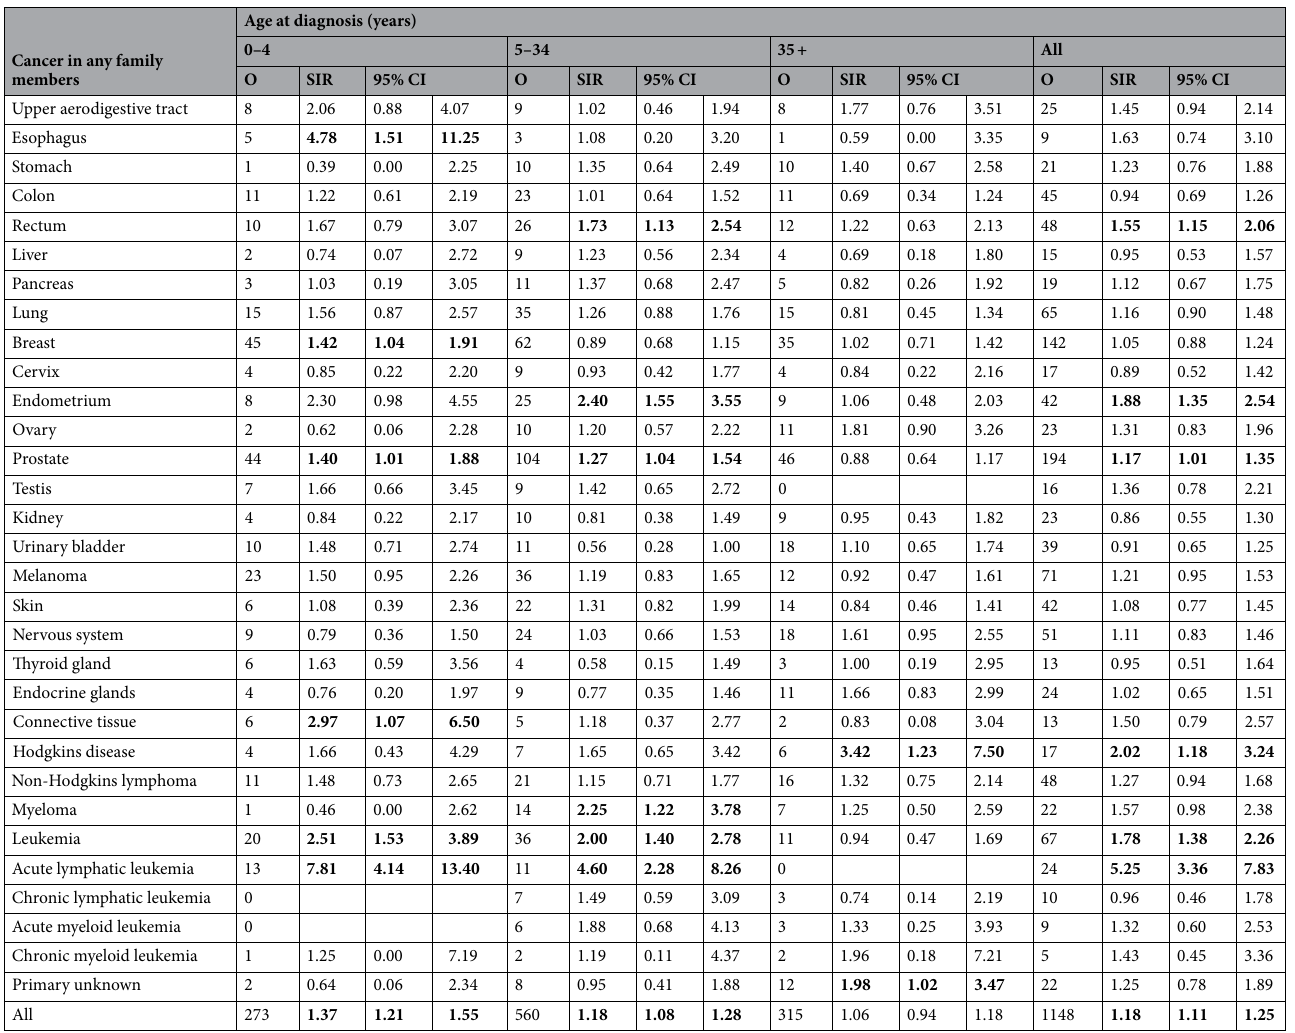
Table 2. Familial risks for acute lymphoblastic leukemia diagnosed at different ages. Bolding indicates that 95% CIs do not include 1.00 (result is significant). O, Observed; SIR, Standardized incidence ratio; CI, Confidence intervals.